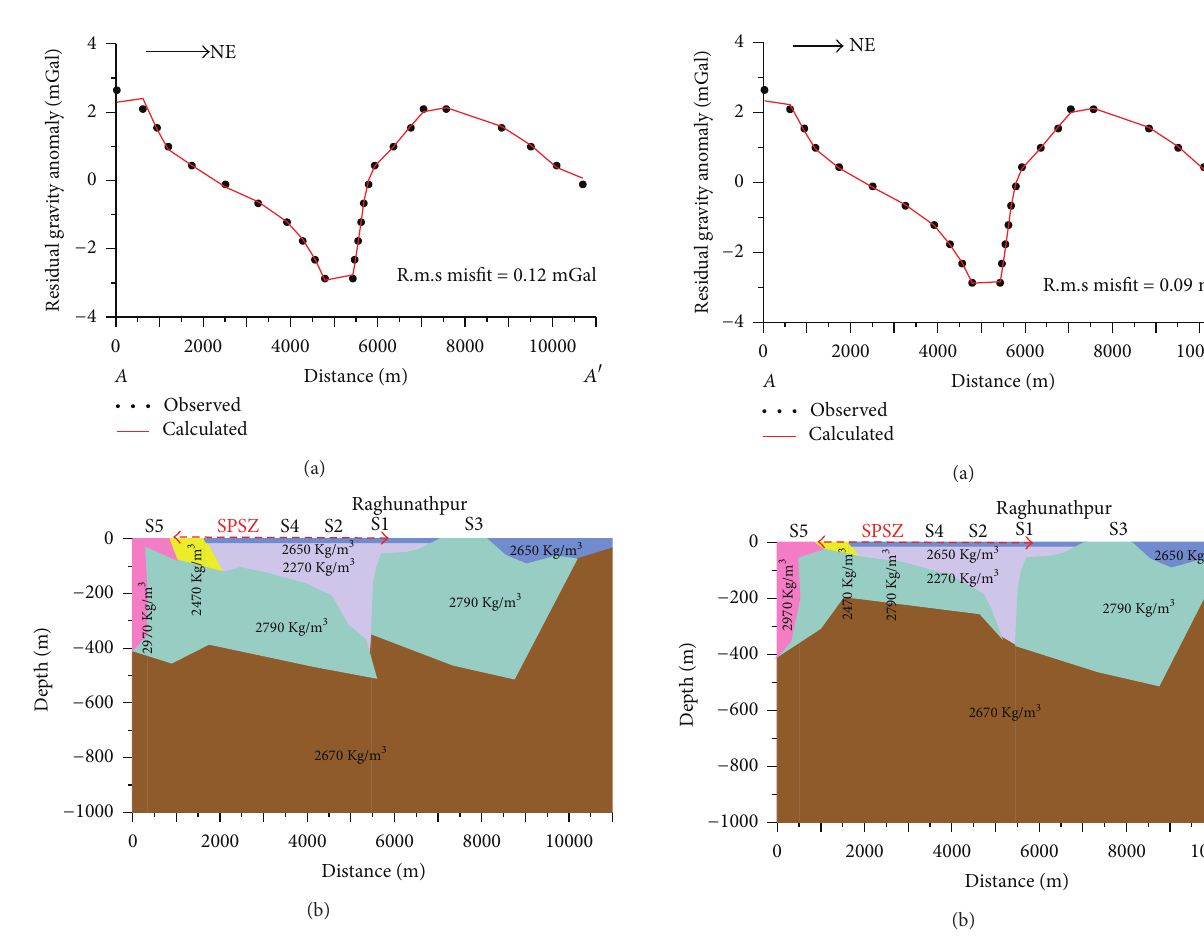
Figure 9: 2D model along AA 󸀠 with resistivity constraint. The r.m.s misfit is 0.09 mGal. The red dashed line in the model section indicating the width of the South Purulia Shear Zone